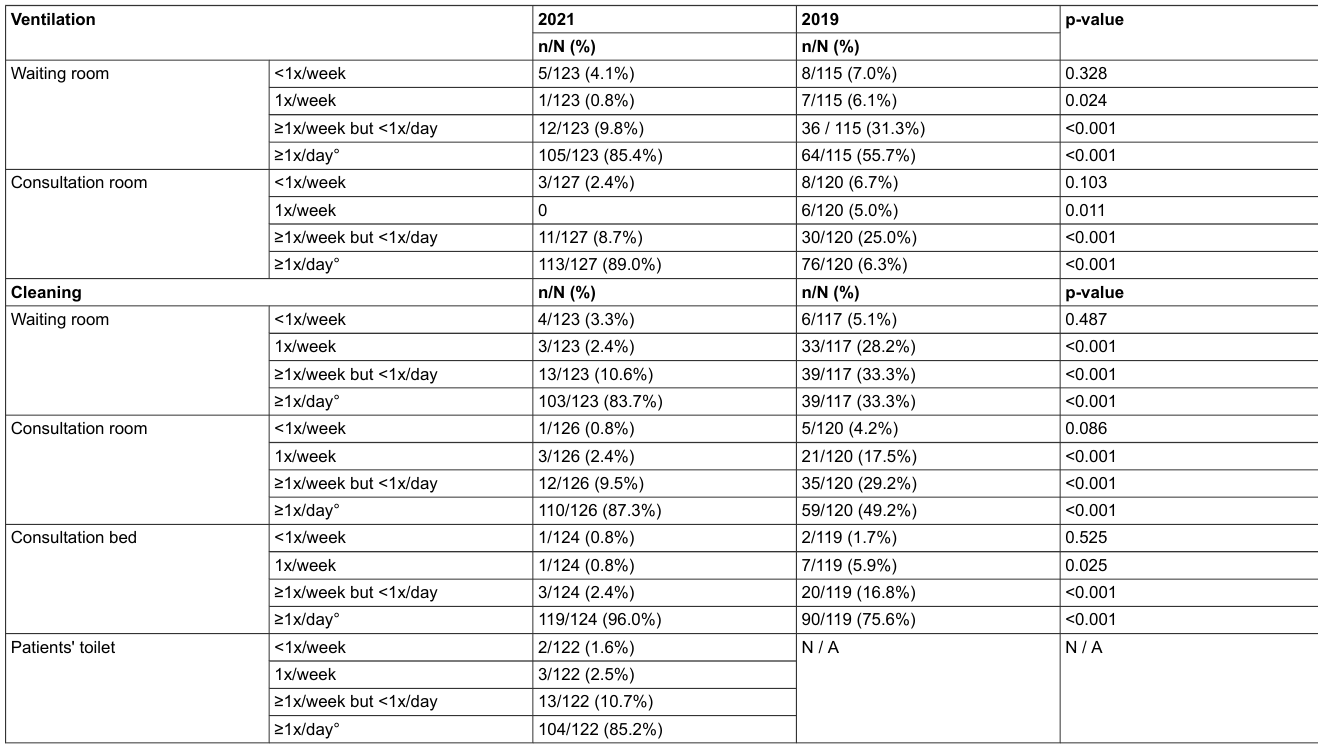
Table 3: Ventilation and cleaning frequency of various areas in the Sentinella network in 2021 and 2019 (127 and 122 answering practices, respectively). Ventilation